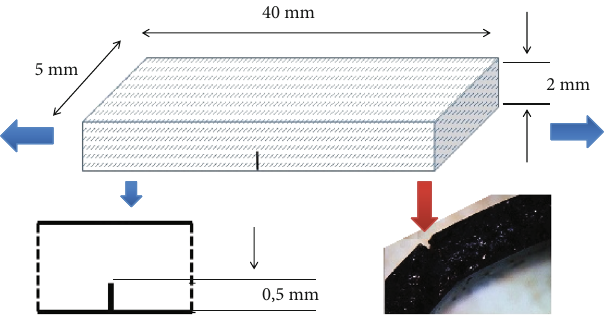
Figure 2: Geometry of sample with controlled incision for tensile tests; microphotograph shows the incision in the bent